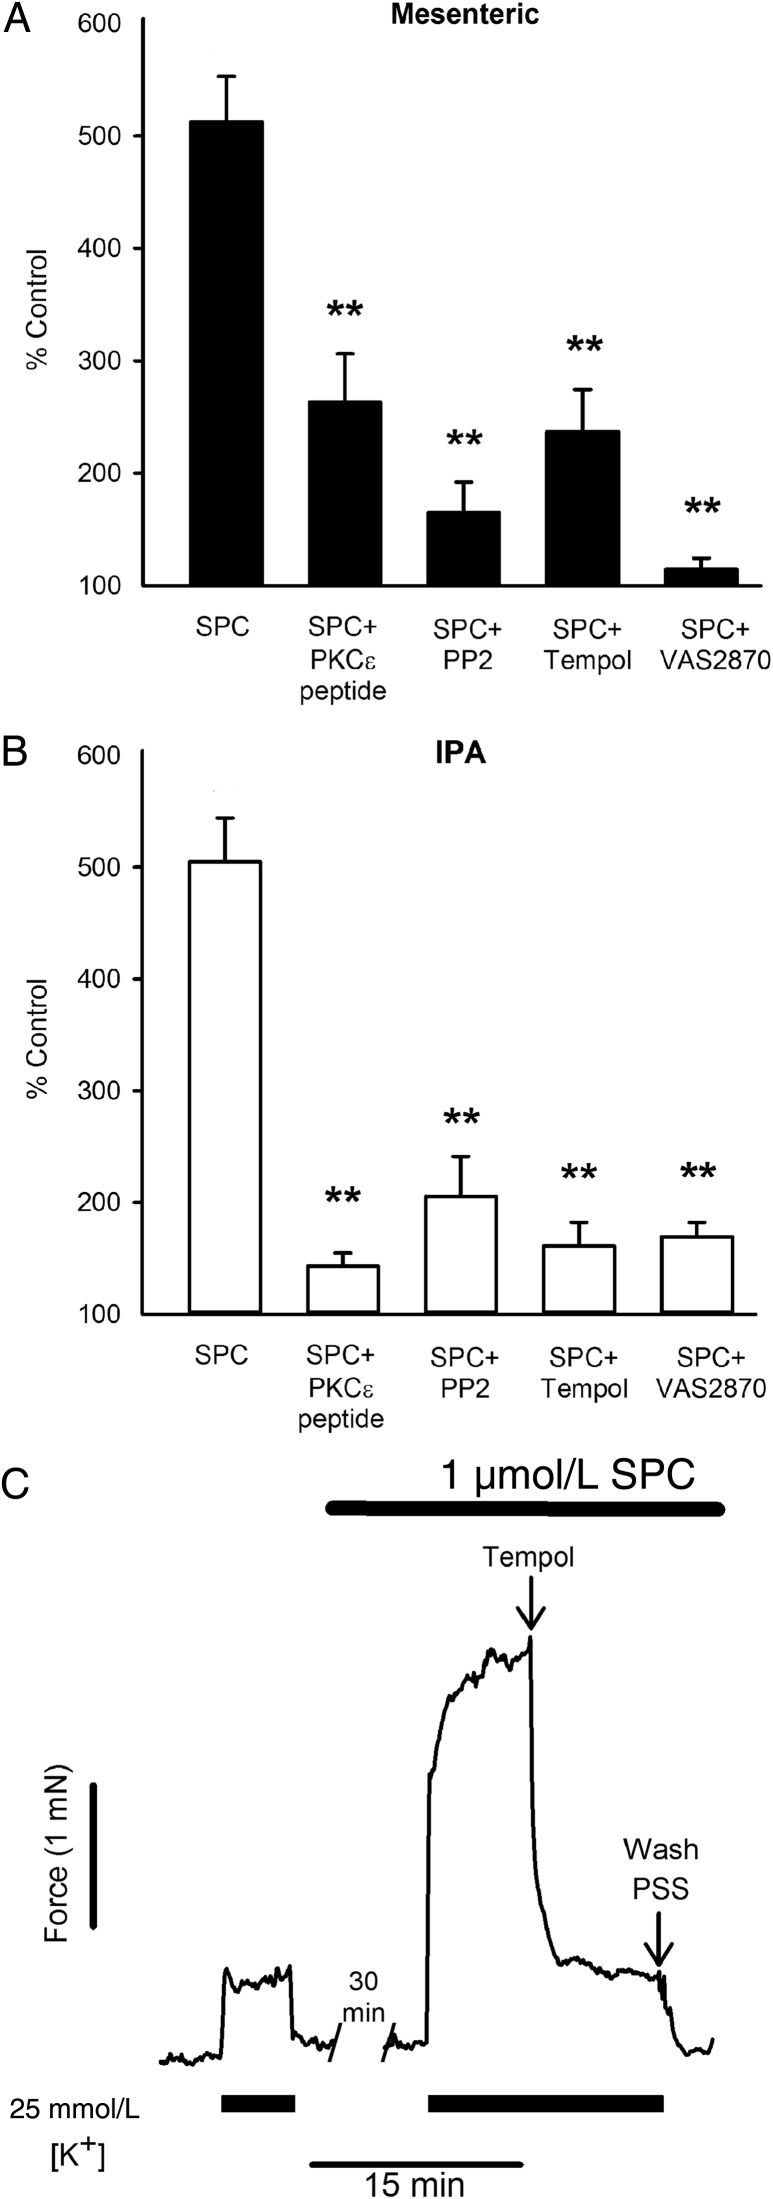
Effects of inhibitors on SPC-induced potentiation in MA and IPA. (A) SPC-induced potentiation (challenge 2) of MA for SPC alone (n = 31, 24 rats), and in the presence of PKCε peptide inhibitor (n = 6), PP2 (Src inhibitor, n = 7), Tempol (n = 11, 8 rats), and VAS2870 (NOX inhibitor, n = 4); 24 rats. (B) SPC-induced potentiation (challenge 2) of IPA for SPC alone (n = 47, 30 rats), and in the presence of PKCε peptide inhibitor (n = 8), PP2 (n = 8), Tempol (n = 11), and VAS2870 (n = 4); 20 rats. (C) Typical trace showing reversal of SPC-induced potentiation in a MA by addition of Tempol (3 mmol/L). Bars = SEM. **P < 0.001 vs. SPC alone; two-way ANOVA, Holm-Sidak post hoc.